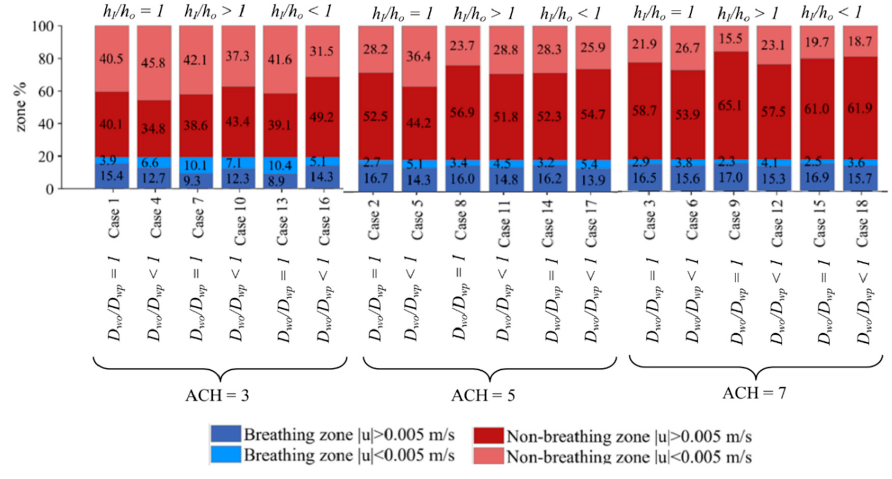
Figure 3. Percentage of dead zones in breathing and non-breathing parts of the domain.